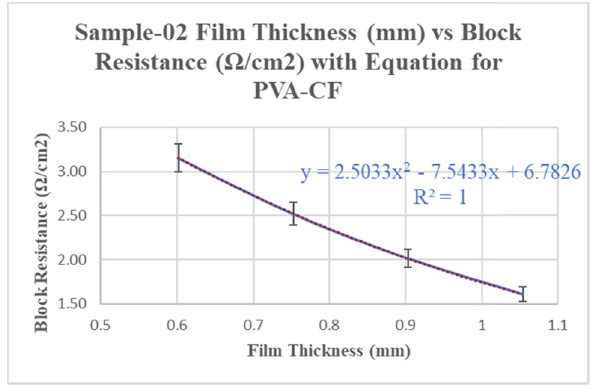
Figure 12: Sample - 02 ( CF:PVA = 0.2:30 ) block resistance ( Ω ) versus thickness ( mm ) with equation for PVA - CF. The dotted lines represent the polynomial fi tted curve and the linear fi tted curve.